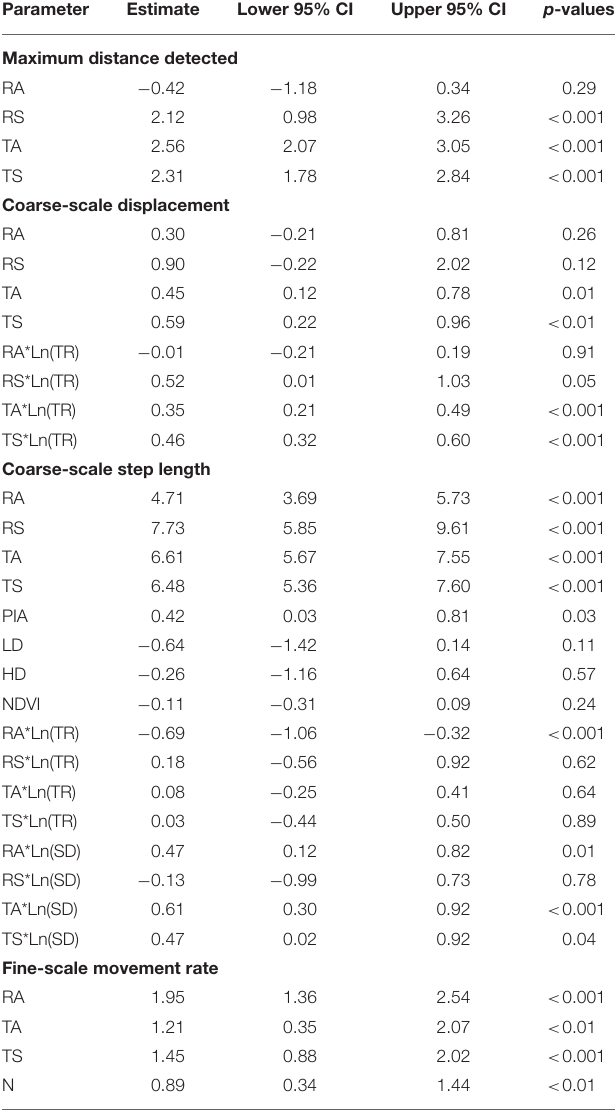
TABLE 3 | Fixed effects estimates from four movement models of resident adult (RA), resident subadult (RS), translocated adult (TA), and translocated subadult (TS) beavers monitored via PIT-, VHF-, and GPS-tags in desert rivers in east-central Utah, USA, from May 2019 to March 2021.